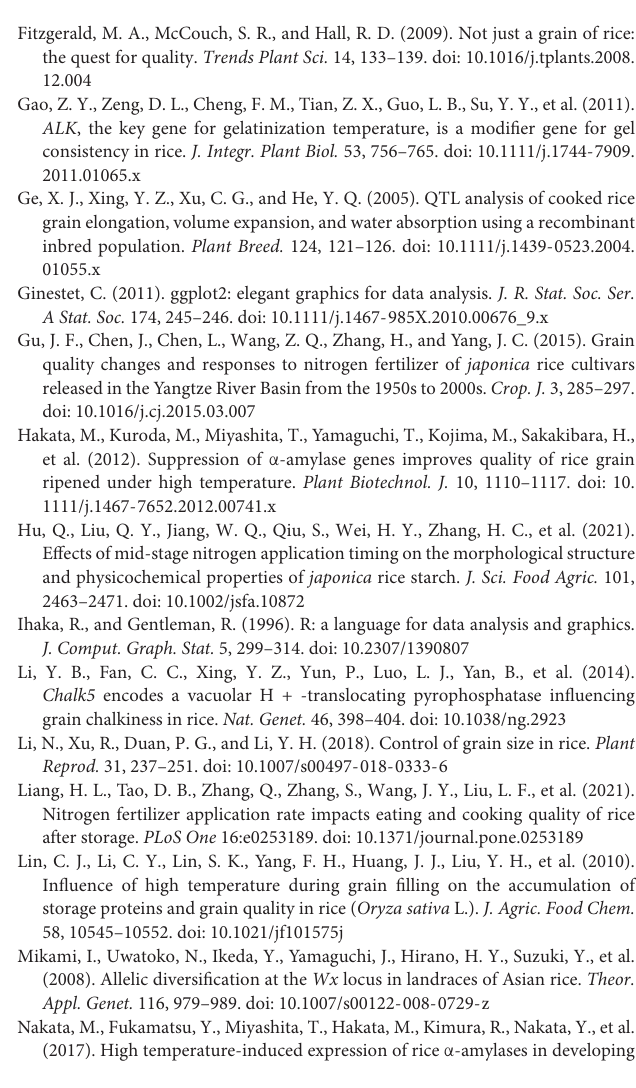
Supplementary Table 1 | Quality traits of tested materials under different conditions. Supplementary Table 2 | Daily temperature and weather conditions during flowering to harvesting period. Supplementary Table 3 | Detailed information about the Wx near-isogenic lines (NILs) and transgenic